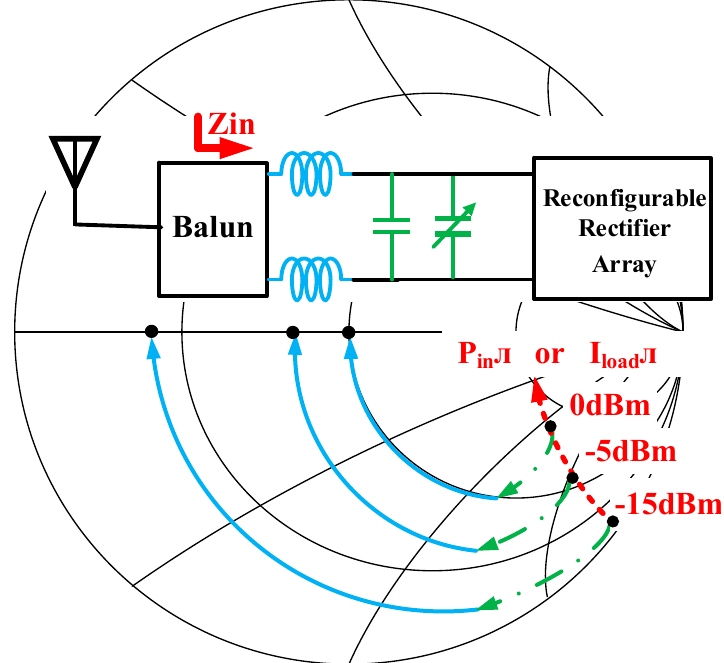
Energies 2022 , 15 , x FOR PEER REVIEW Figure 4. The proposed adaptive impedance matching network. Figure 4. The proposed adaptive impedance matching network.